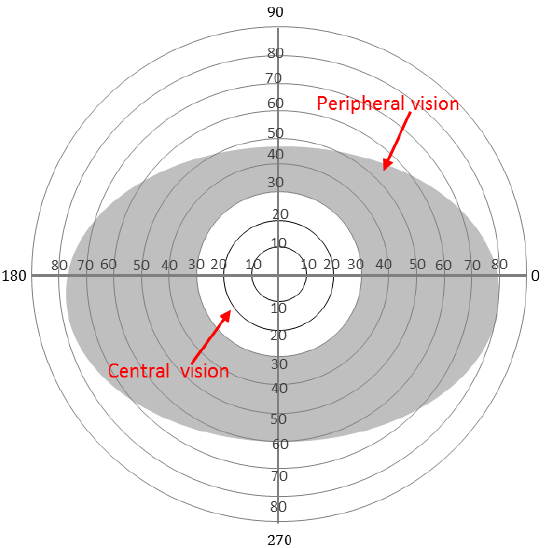
Figure 1. The healthy visual field extent for both eyes. The white circle in the middle represents the central visual field, while the grey area represents the peripheral visual